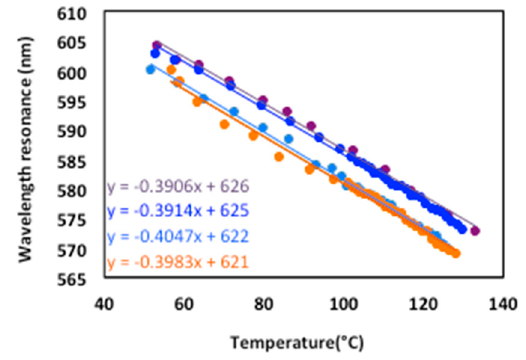
Figure 11. Resonance wavelength 𝜆 𝑅 (cid:4666) 𝑇 (cid:4667) versus temperature—measurement repeatability.